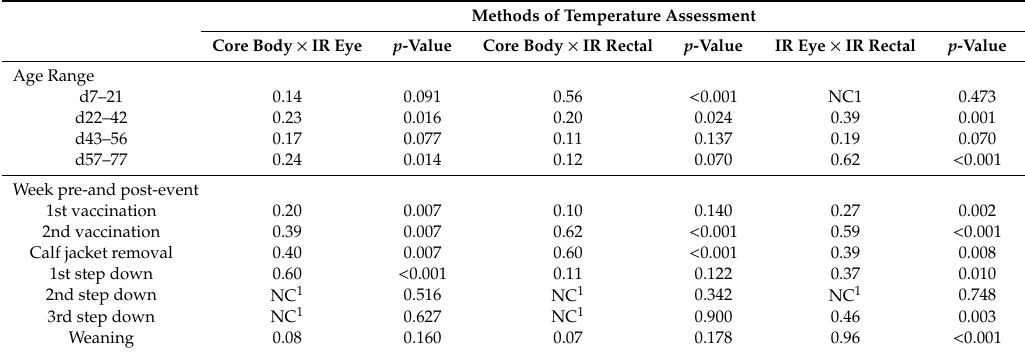
Table 6. Pearson correlation coe ffi cients between methods of temperature assessment over specific age ranges and during the 7 days pre- and post-management